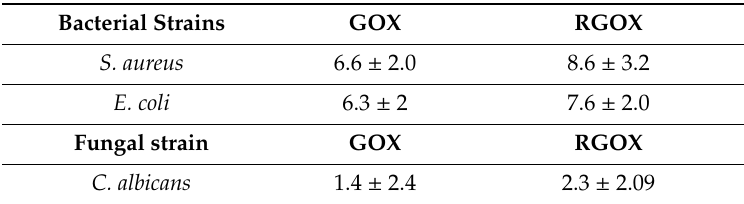
Table 1. Zones of inhibition observed (in mm units) against microbial